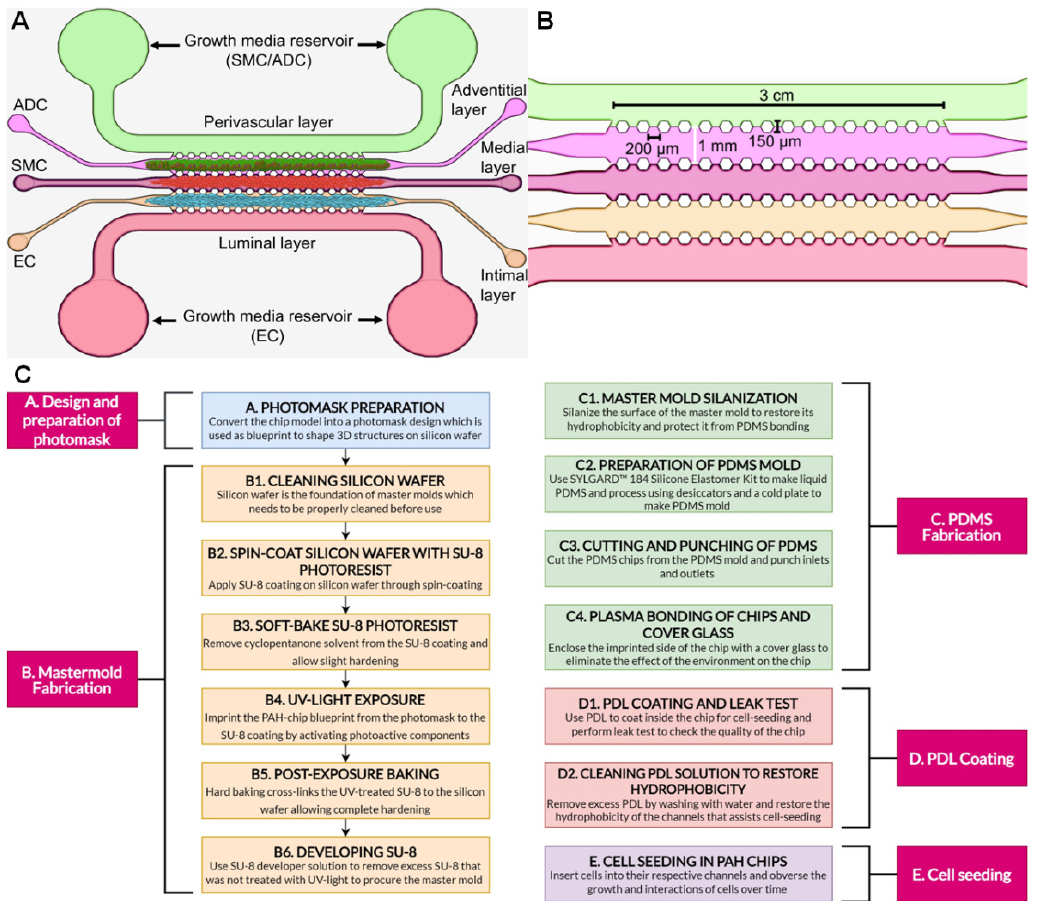
Figure 1. ( A , B ) PAH-chip design. ( A ) Five straight microchannels mimicking the biological structure of a pulmonary artery: growth media for smooth muscle cells (SMCs) and adventitial cells (ADCs) in the perivascular layer, growth media for endothelial cells (ECs) in the luminal layer, ADCs in the adventitial layer, SMCs in the medial layer, and ECs in the intimal layer. ( B ) Dimensions of the PAH- chip: The distance covered by pillars within the chip is 3 cm, inter pillar distance is 200 µm, the pillar height is 150 µm, and each set of pillars is separated by 1 mm. ( C ) A step-by-step flowchart of the PAH-chip manufacturing